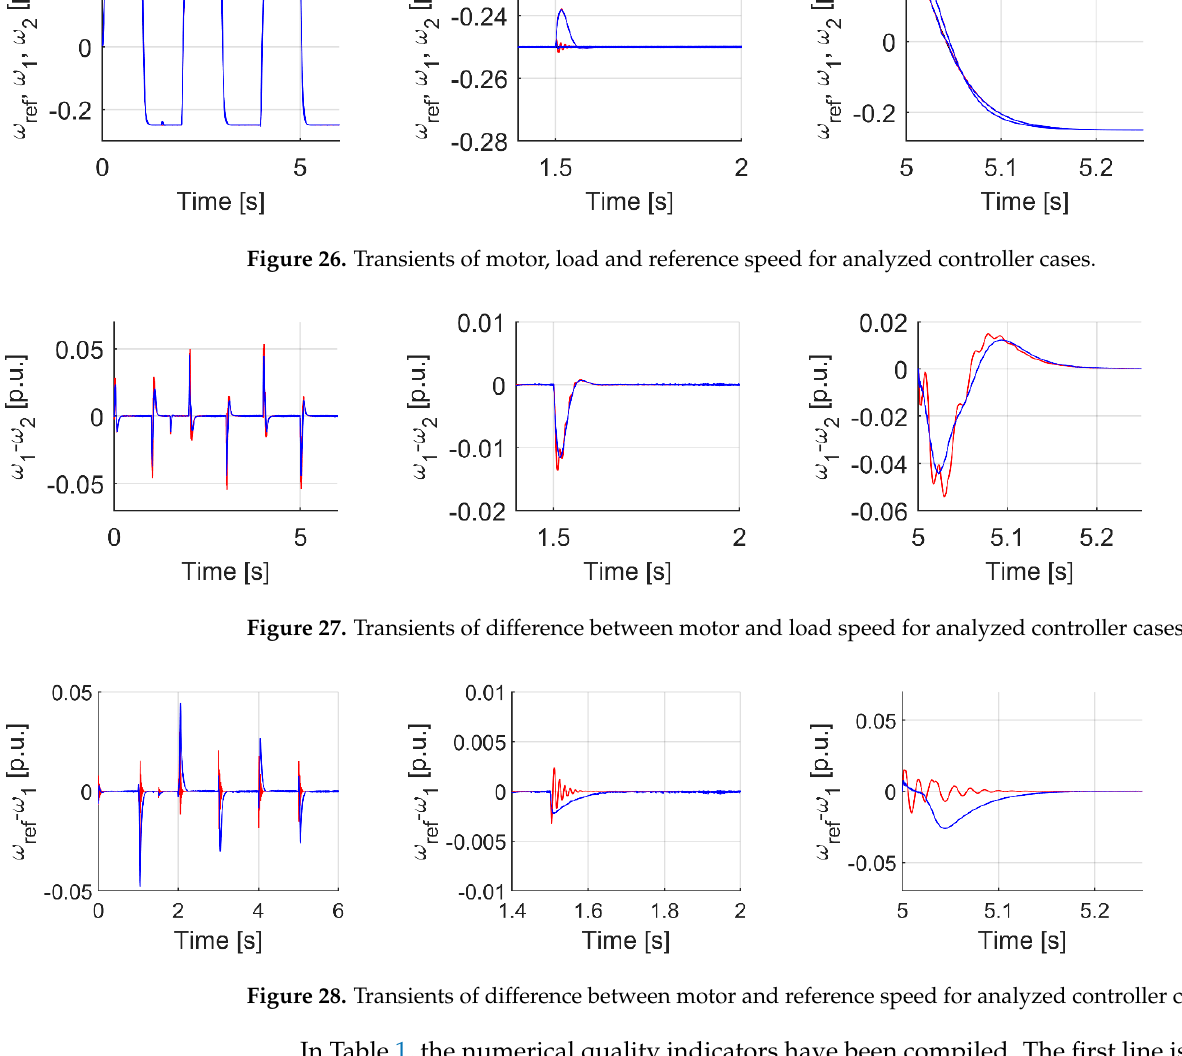
Table 1. The comparison of numerical quality indicators for different